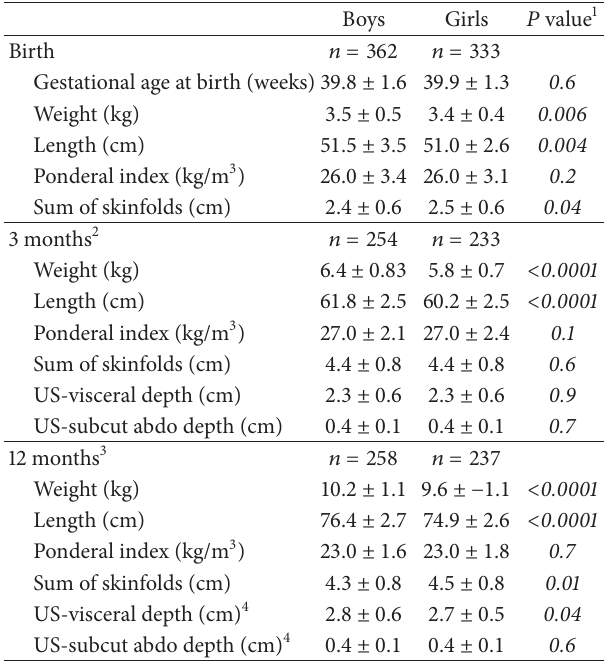
Table 4: Summary of measurements in Cambridge Baby Growth Study